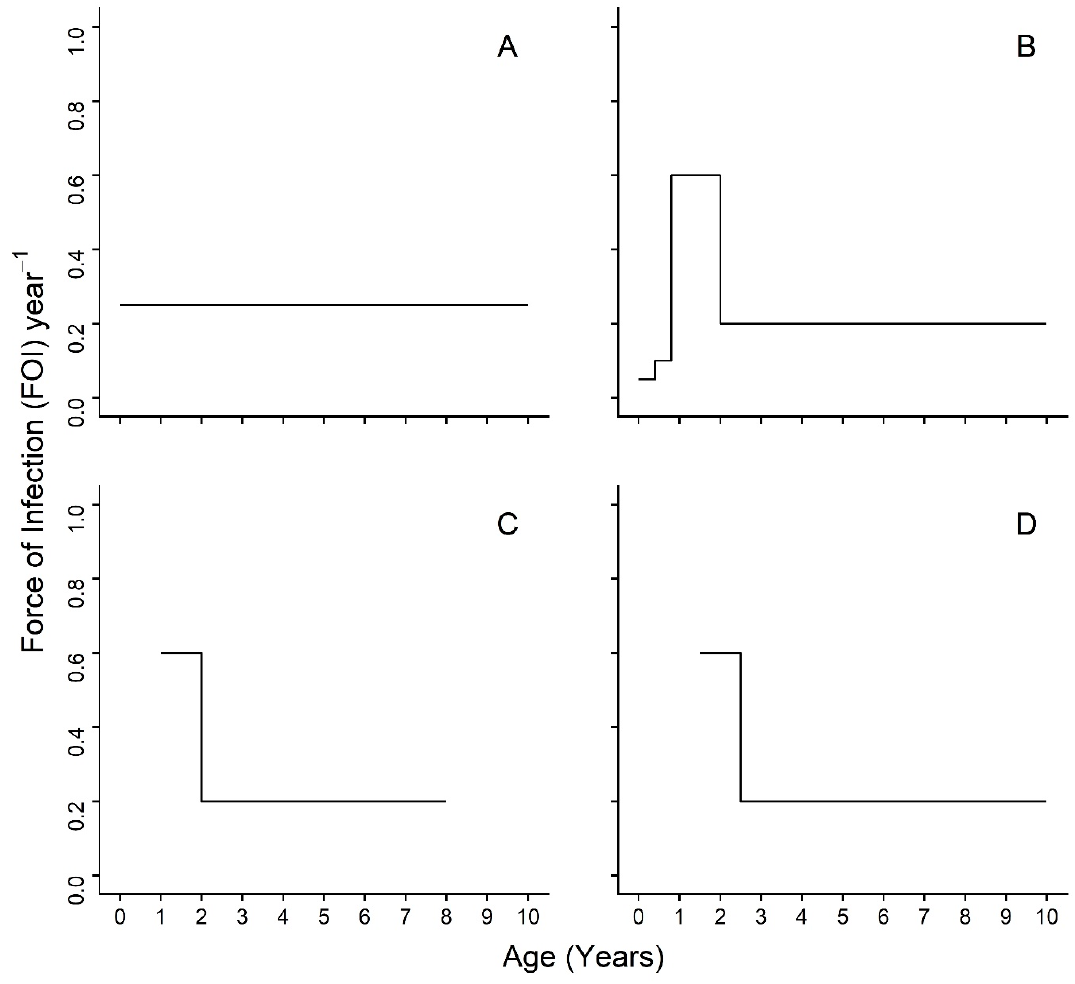
Figure 1. Schematic representation of the possible age-specific force of infection transmission patterns for Peste des petits ruminants virus (PPRV). Possible transmission routes include ( A ) constant force of infection from birth due to environmental exposure and ( B ) horizontal transmission during routine social activities at the age of independence and then at the time of breeding; ( C ) the expected patterns among the sheep and goats in the five age group dataset dominated by horizontal transmission due to breeding; ( D ) the expected pattern among cattle in the five age group dataset dominated by horizontal transmission due to socialization at age of independence.